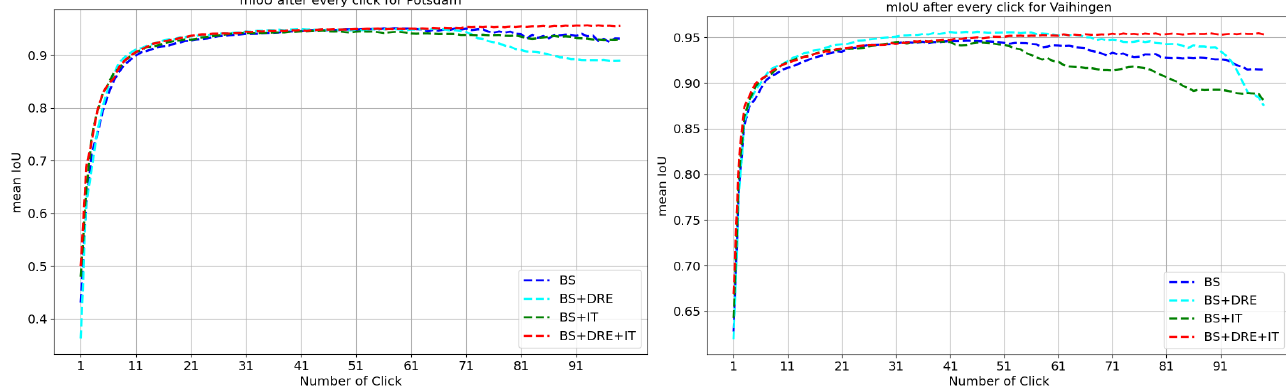
Figure 15. CG ablation results for the surface category in the Potsdam and Vaihingen datasets. The abbreviations “BS” and “IT” indicate the baseline and incremental training strategy, respectively. A smoothly rising curve shows better CG